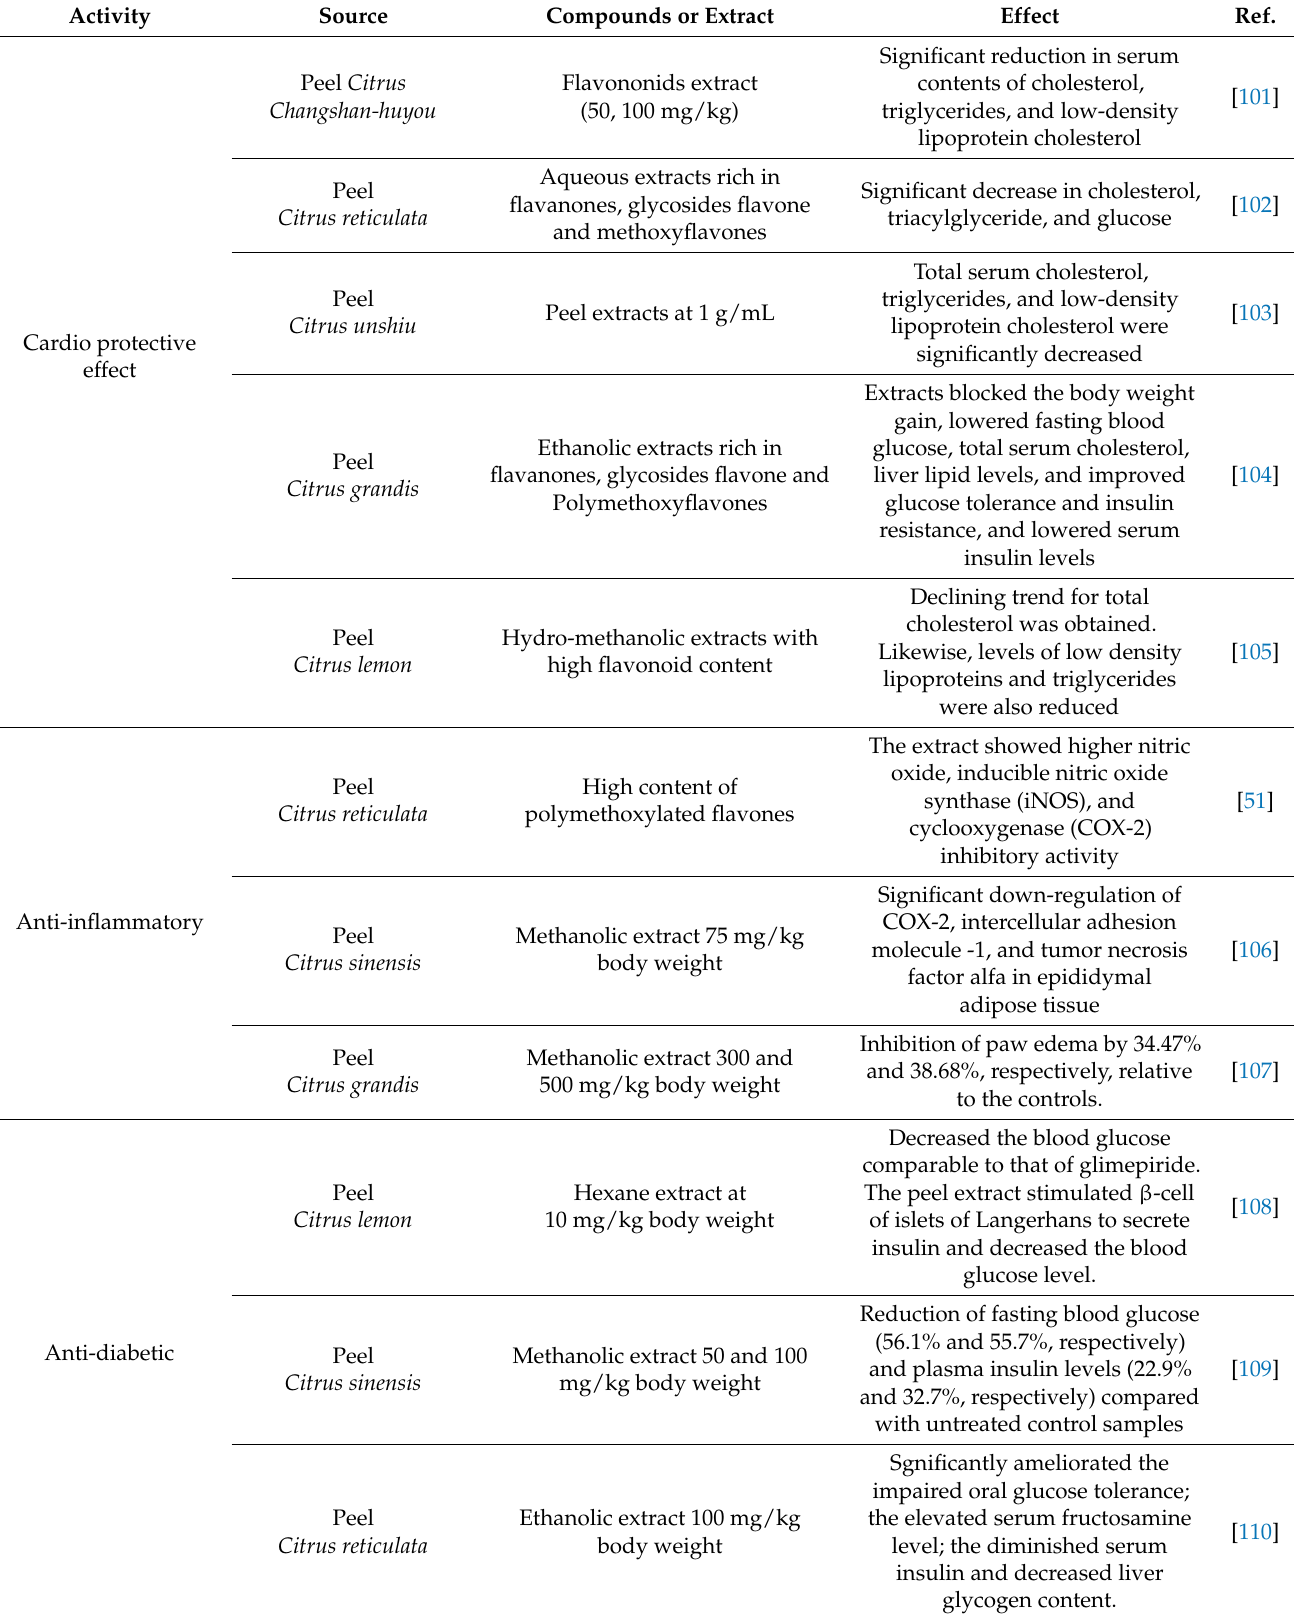
Table 3. Health benefits of peel extracts obtained from different Citrus